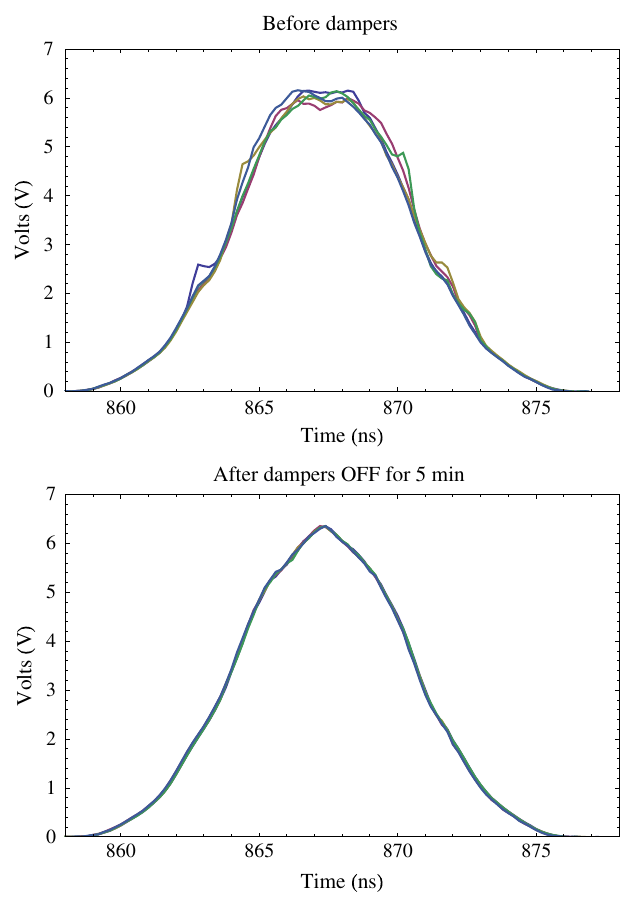
FIG. 7. The before and after effects of using the damper to stop the dance. The distribution after the dampers have stopped the dancing is to make the distribution more triangular in